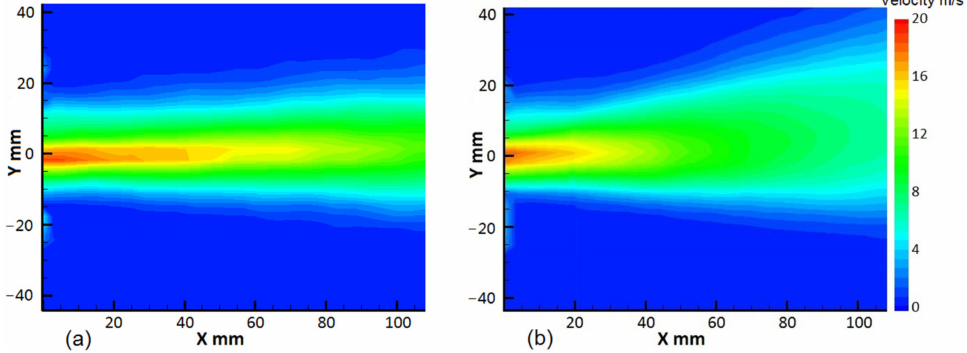
Figure 6. Time average velocity distribution of nozzle B without ( a ) and with ( b )